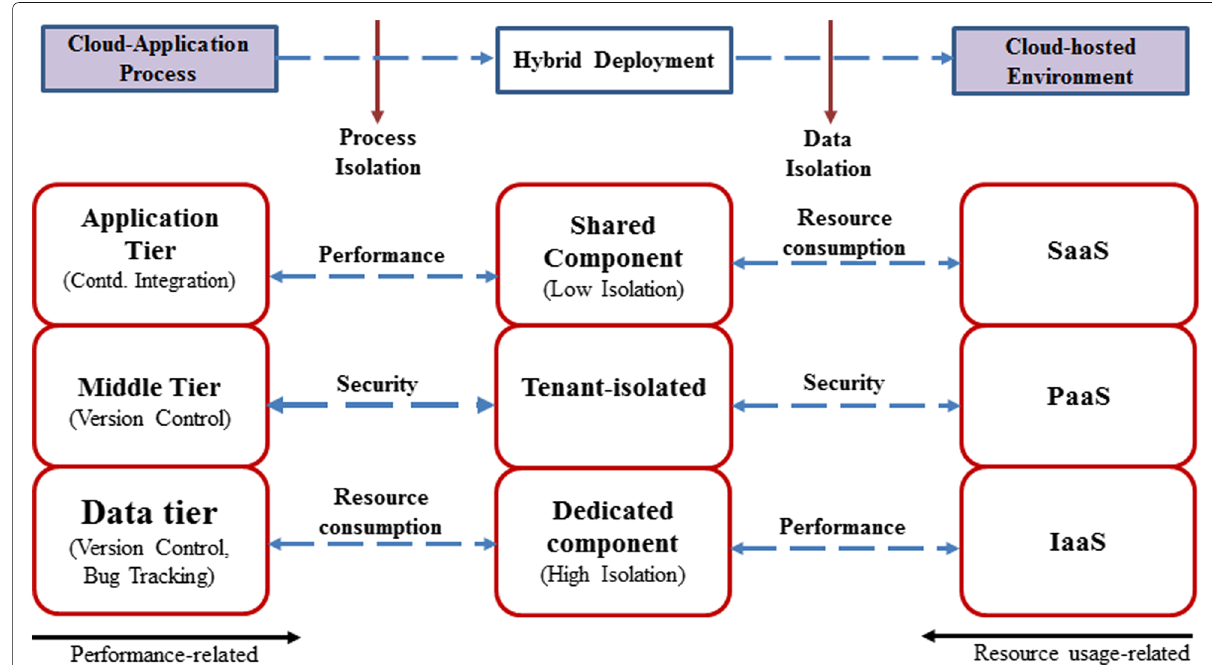
Fig. 7 Mapping of Degrees of Isolation to Cloud-hosted GSD Process and